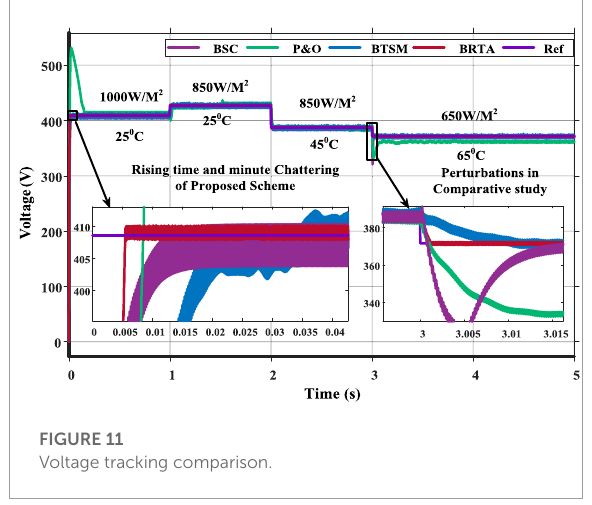
FIGURE 11 Voltage tracking comparison.